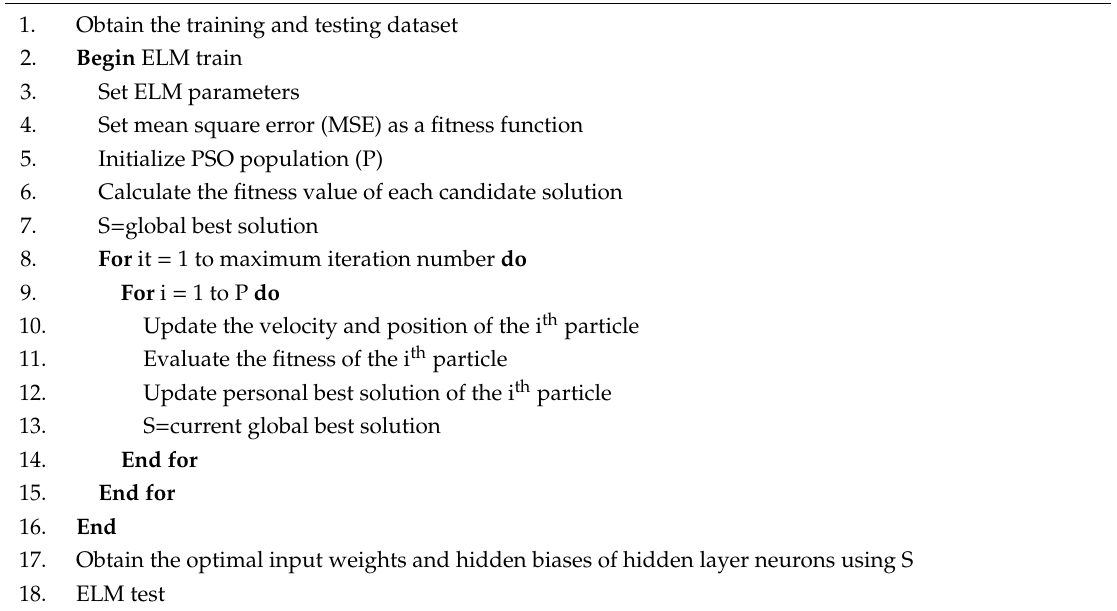
Algorithm 2 : The algorithmic flow of